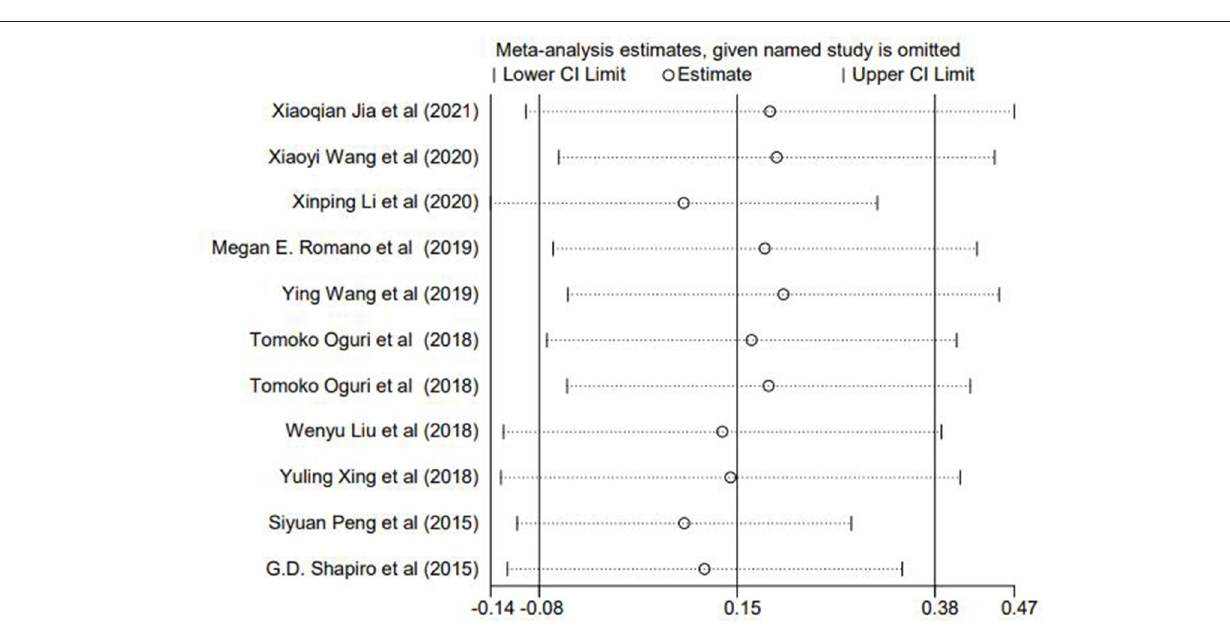
FIGURE 3 | Sensitivity analyses after omitting each